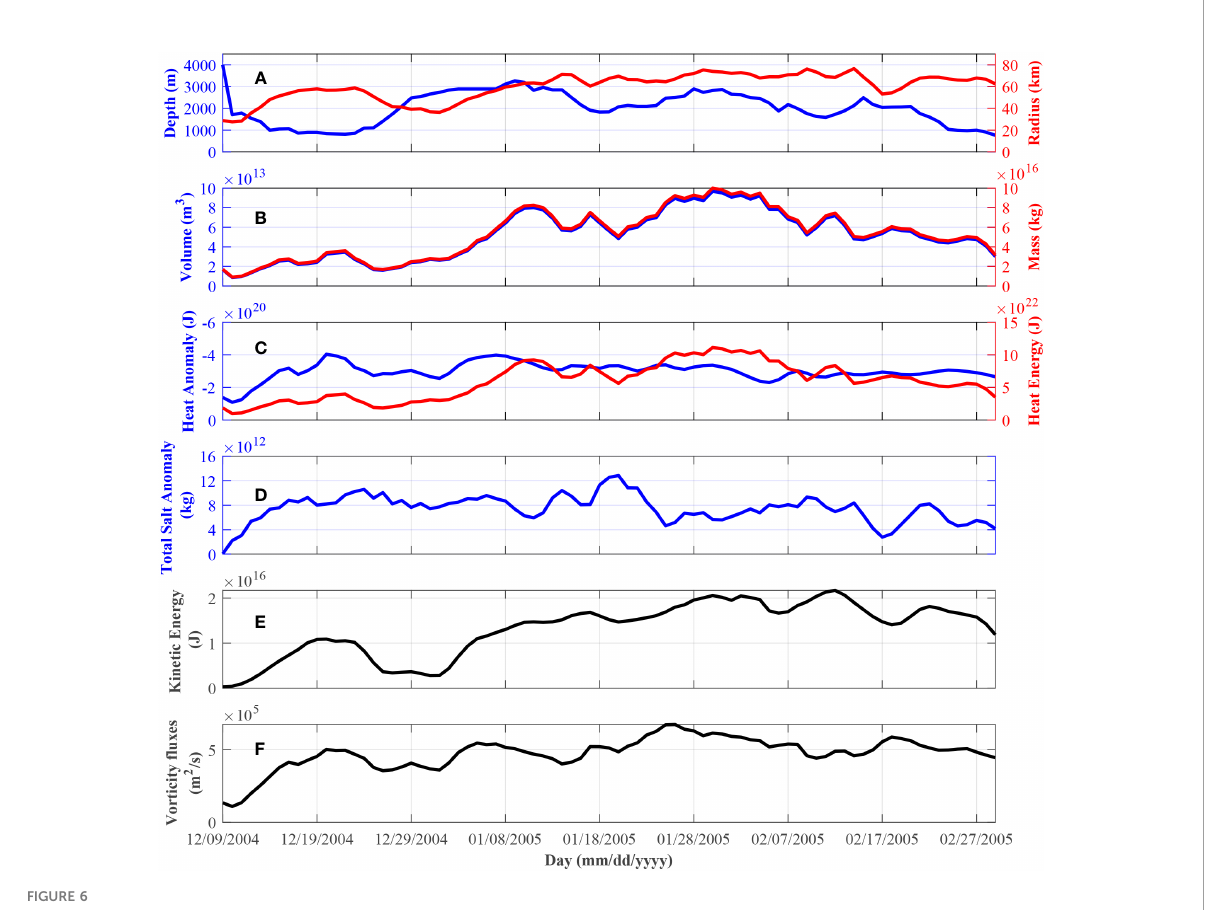
FIGURE 6 Time series of (A) depth and mean radius of the eddy, (B) total mass and volume, (C) total heat for the eddy and its anomalies, (D) total salt Z ​ r ( u 2 + v 2 ) dV ), and (F) vertical averaged vorticity fl uxes from December 9, 2004 to March 1, 2005. Total anomalies, (E) total kinetic energy ( 1 2 salt is calculated as the salinity multiply by the total mass of the eddy. Anomalies are calculated as the daily value minus the 1-year average at that